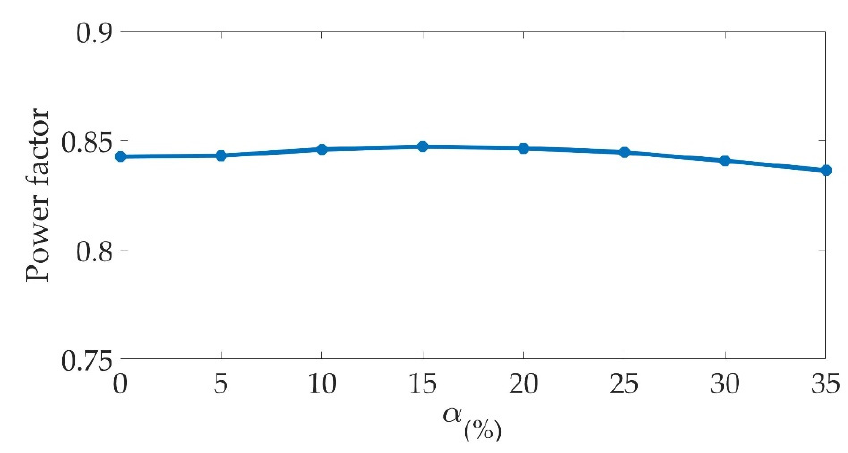
Figure 18. Power factor with different ratios α ( β = 50%).